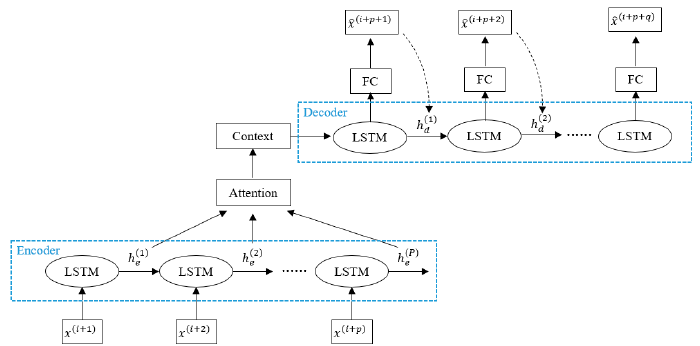
Figure 4. Architecture of LAED Model.